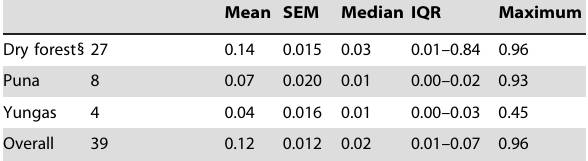
Table 2. Dwelling infestation by triatomine bugs in 39 municipalities within Chagas disease risk areas, Cochabamba, Bolivia, 2000–2011*: eco-regional descriptive